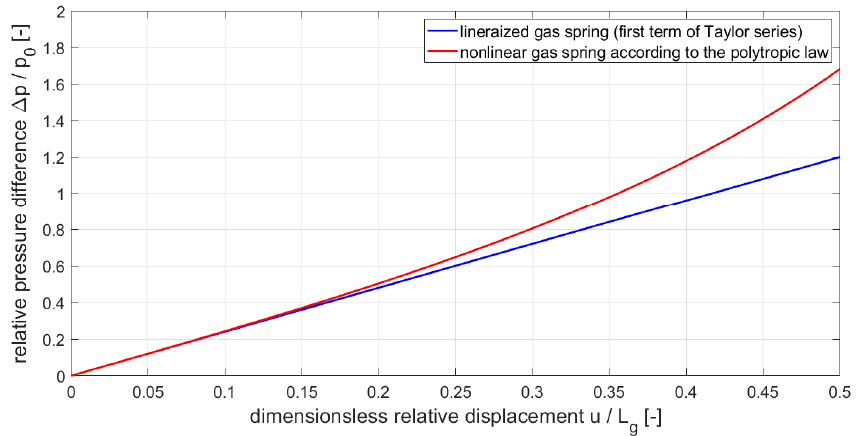
Figure 3. Comparison of linear and nonlinear gas spring stiffness function ∆ p / p 0 .